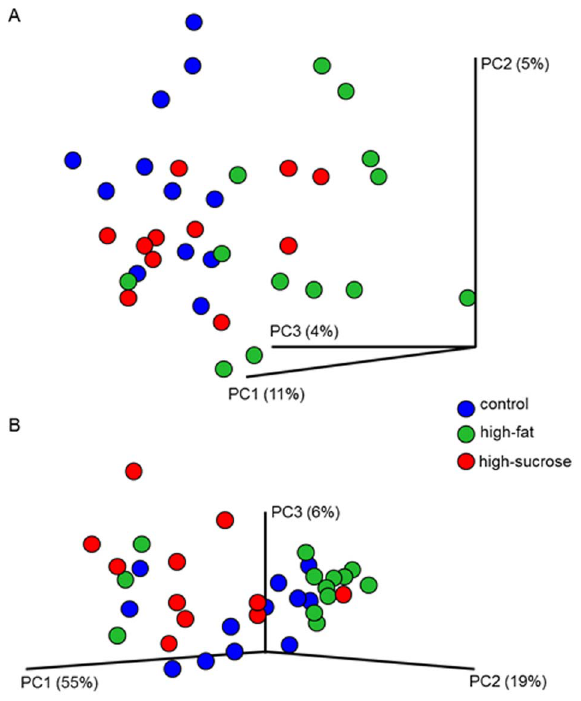
Figure 6. 3D plots of the unweighted and weighted PCoA of cecum. Plots are constructed from the three most primary principal components of the PCoA, with A) showing the unweighted analysis and B) showing the weighted analysis which takes the abundance of the bacteria into account. Both plots visualize that the cecal GM of mice fed a high-fat diet diverge from that of mice fed either a high-sucrose or a control diet. doi:10.1371/journal.pone.0103398.g006 (weighted, high-fat vs. control, p = 0.088, R = 0.060, high-fat vs. high-sucrose p = 0.062, R = 0.076, control vs. high-sucrose p = 0.14, R= 0.046). 3D plots constructed from the three primary PC’s of the unweighted and weighted PCoA visualized the results (cecum, figure 6A and B. Feces,not shown): The GM of mice fed a high-fat diet diverged from theGM of mice fed a high-sucrose or a starch-rich control diet in thePCoA plot constructed from unweighted data (Figure 6A), andtaken into account the bacterial abundance, the same tendencywas seen (Figure 6B). The Firmicutes phylum also increased incecum of the high-fat fed mice (37.7%, 24.1% and 22.4%p = 0.0062, FDR p = 0.056, for high-fat, control and high-sucrosediet group, respectively), primarily within the family Ruminococ-caceae (20.31%, 13,.65% and 12.16%, p = 0.00062, FDRp = 0.014, table 6), whereas the Bacteroidetes phylum decreased near-significantly in the high-fat group (17.0%, 26.4% and 23.8%, p = 0.052, FDR p= 0.12 for high-fat, control and high-sucrose diet group, respectively), primarily within an unclassified genus belonging to the family S24-7 (0.14%, 0.34% and 0.29%, p = 0.025, FDR p = 0.19, for high-fat, control and high-sucrose respectively, table 5), resulting in a significantly reduced B/F ratio in the high-fat fed mice, (median 0.51, 0.88 and 1.13 for high-fat, control and high-sucrose diet group, respectively, high-fat vs. control p = 0.0036, high-fat vs. high-sucrose p= 0.0021, high- sucrose vs. control p = 0.68). G tests revealed no diet-induced difference in presence or absence of bacterial species in neither feces nor